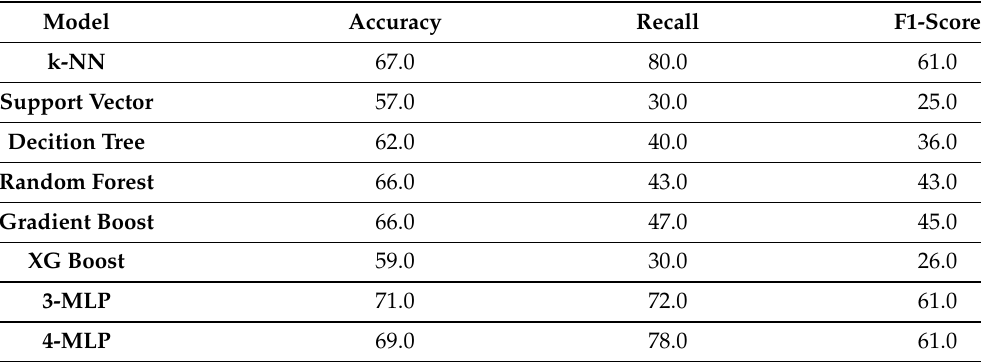
Table 3. Results of General Model with